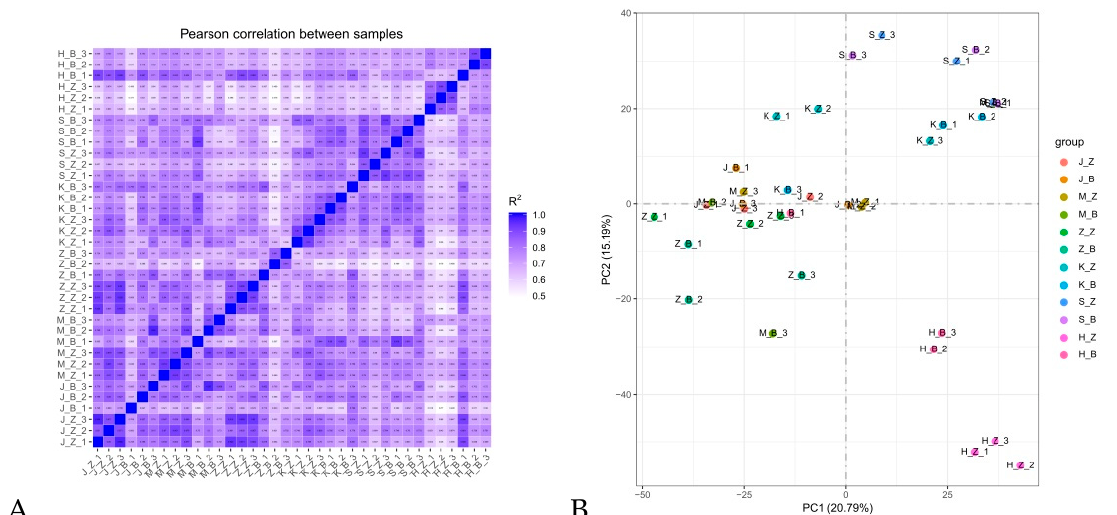
Figure 2. Quantitative analysis of each intestine sample. ( A ) Heat map of correlation between samples. The higher the correlation coefficient between samples, the closer the expression pattern is. ( B ) Principal component analysis result graph. Ideally, the intergroup samples in the PCA diagram should be scattered and the intra-group samples should be clustered together. S_Z: the duodenum of healthy rabbits, S_B: diarrhea in the duodenum of rabbits, H_Z: healthy rabbit ileum, H_B: diarrheal rabbit ileum, K_Z: healthy rabbit jejunum, K_B: rabbits with diarrheal jejunum, M_Z: healthy rabbit cecum, M_B: rabbits with diarrheal cecum, J_Z: healthy rabbit colon, J_B: colon of rabbits with diarrhea, Z_Z: healthy rabbit rectum, Z_B: rectum of rabbits with diarrhea.